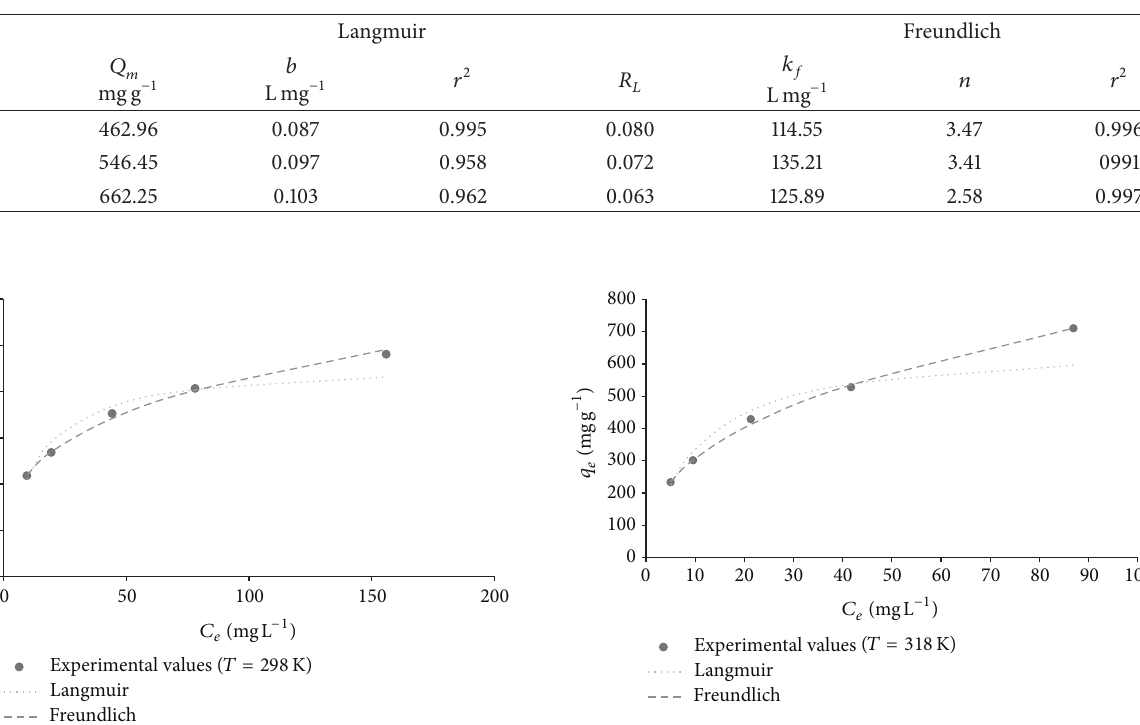
Table 1: Langmuir and Freundlich constants for the adsorption of MB onto CHAC